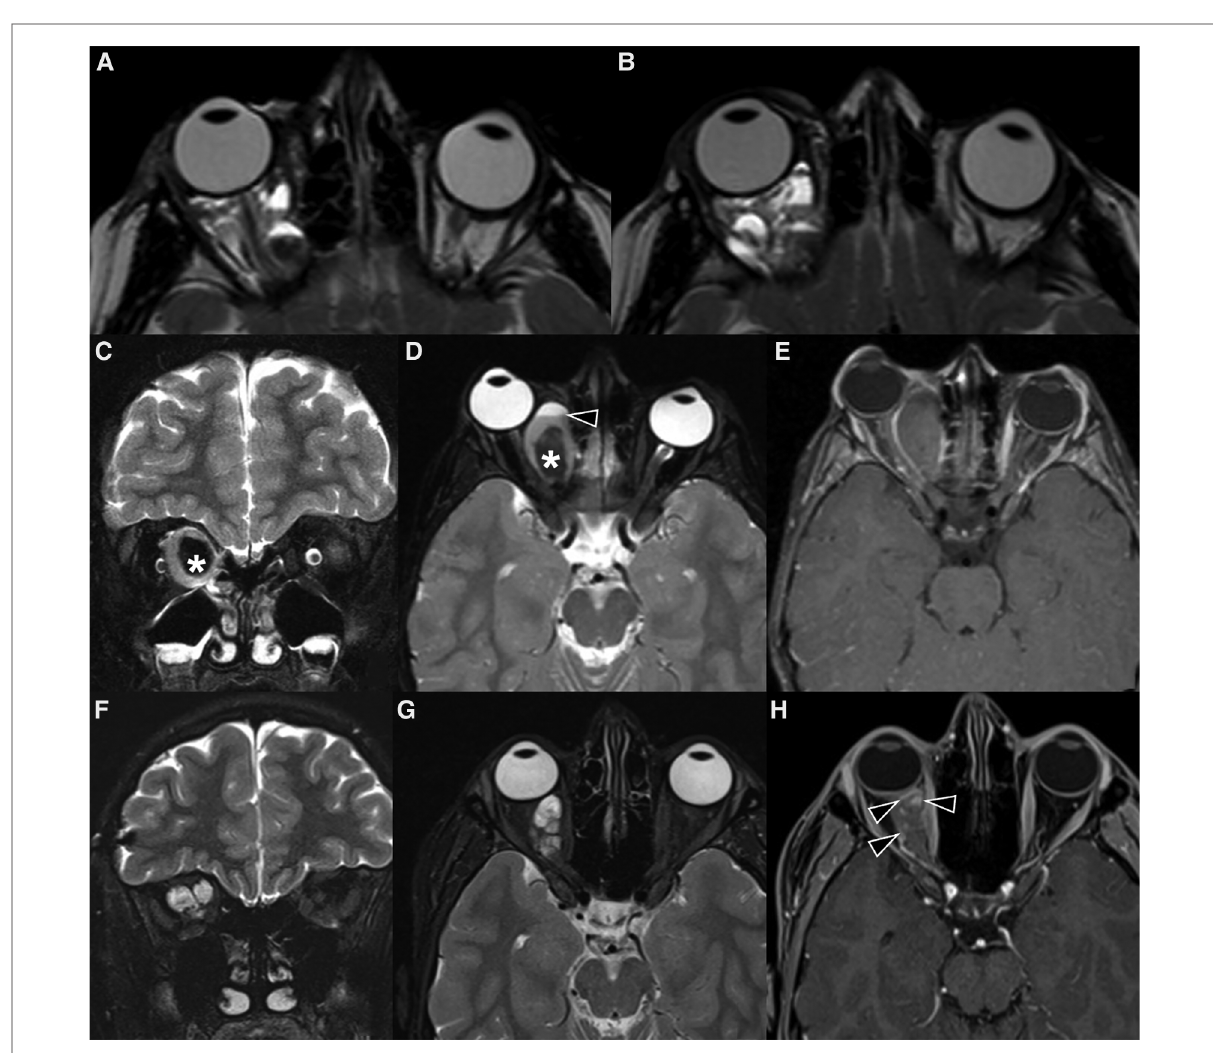
FIGURE 10 Imaging of lymphatic malformations. ( A,B ) MRI of a 11-year-old boy with subacute disturbances in visual motility and subtle ptoptosis of the right eye. Axial T2 weighted images show a right intraorbital multiloculated, polylobate and poorly de fi ned mass with fl uid- fl uid levels, which extends into the extra and intra-conal compartments. The fi ndings were virtually pathognomonic of a lymphatic malformation. ( C – H ) MRI of a 6-year-old girl with acute right orbital swelling and proptosis. ( C – E ) Coronal STIR ( C ) and axial T2 weighted images ( D ) show a multicompartmental expansile mass with marked compression on the optic nerve and proptosis; the lesion also demonstrates a central marked hypointensity (asterisk in C,D ) with no evidence of enhancement on axial post-contrast fat-sat T1 ( E ). The mass was partially removed surgically, and histology revealed veno-lymphatic malformation. ( F-H ) 10-year follow-up MR images show how the mass has markedly reduced in size. The multiloculated architecture is more apparent ( F,G ), with thin intervening septa and blood- fl uid levels; on post-contrast T1-w sequence only the septa enhance ( H